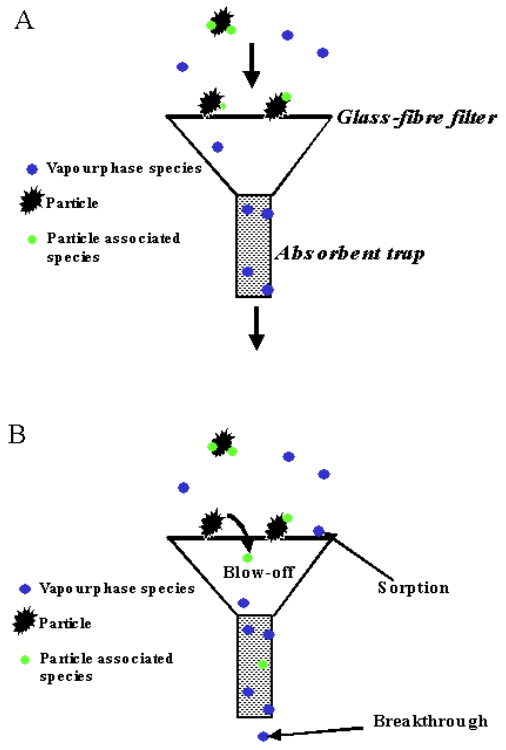
FIGURE 2. (A) Schematic of active air sampling. Air is drawn through the filter and adsorbent trap by a motor. Particle-associated species are retained by the filter, and vapour phase–associated species by the adsorbent trap. (B) Artifacts of active air sampling include blow off (species that were associated with particles, desorb, and are retained by adsorbent trap rather than the filter), breakthrough (vapour-phase species breakthrough from the adsorbent trap), and sorption of vapour-phase species to the